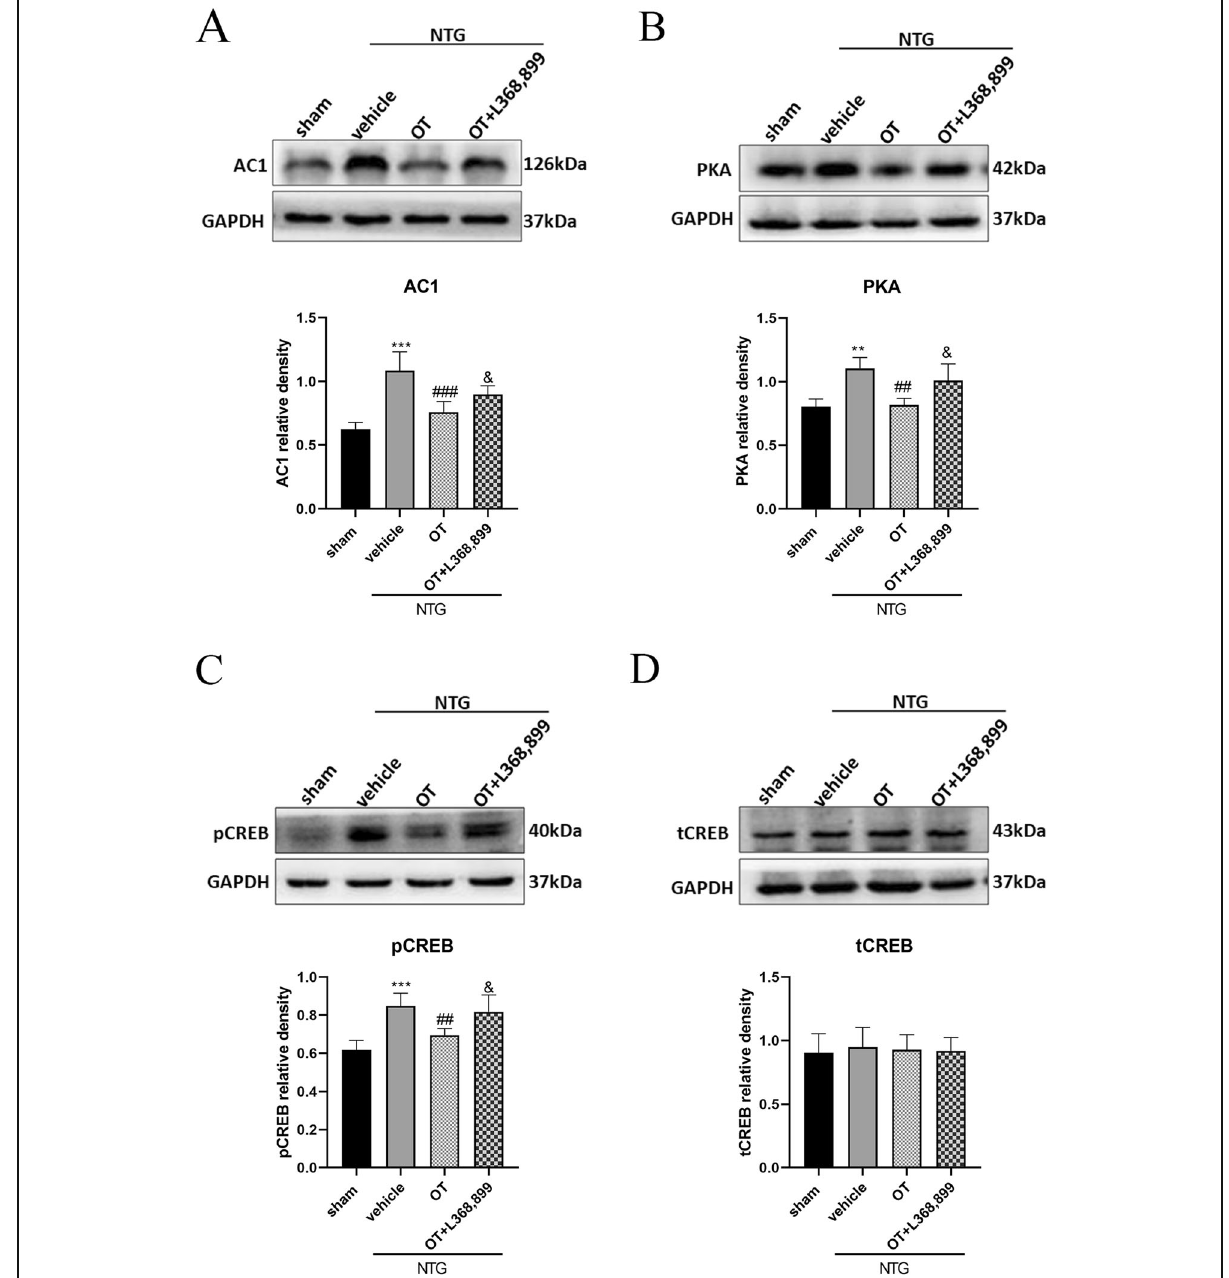
Fig. 9 Effect of OT on the AC1/PKA/pCREB pathway. A , B and C WB results showed that the protein levels of AC1 ( A ), PKA ( B ), and pCREB ( C ) were significantly elevated in the NTG + vehicle group compared with the sham group. The expression levels of these three proteins after OT treatment were reduced, while L368,899 prevented the effect of OT. D There was no significant difference in CREB expression among the four groups. One-way ANOVA with Dunnett ’ s post hoc test, n = 6/group; ** p < 0.01, *** p < 0.001 vs. the sham group; ## p < 0.01, ### p < 0.001 vs. the NTG + vehicle group; & p < 0.05 vs. the NTG + OT